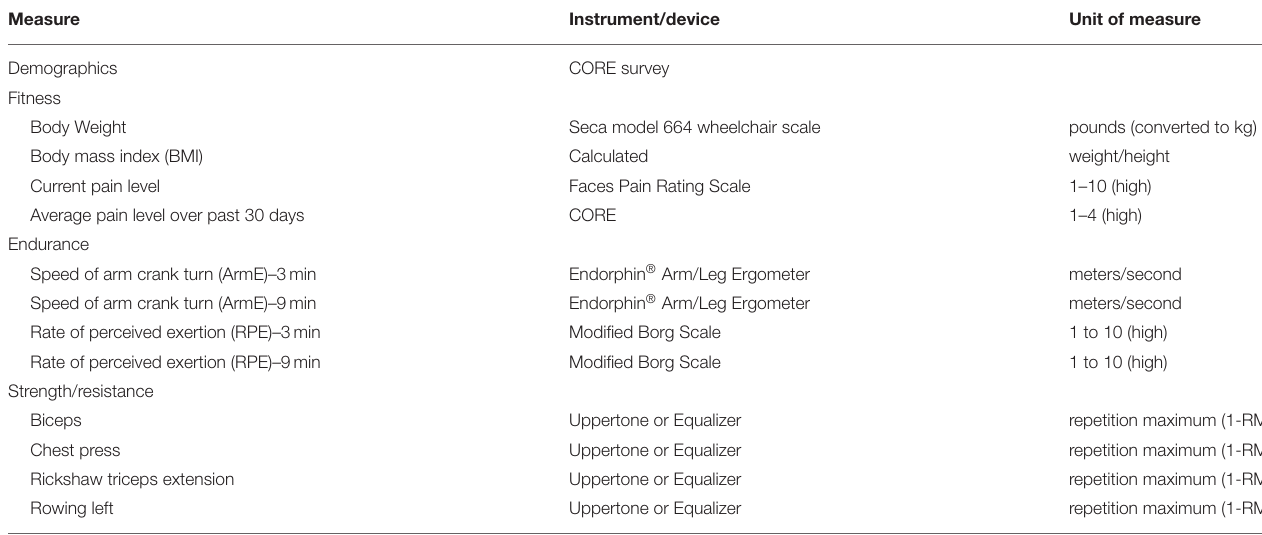
TABLE 1 | Assessments made prior to (T-1) and after T-2) exercise